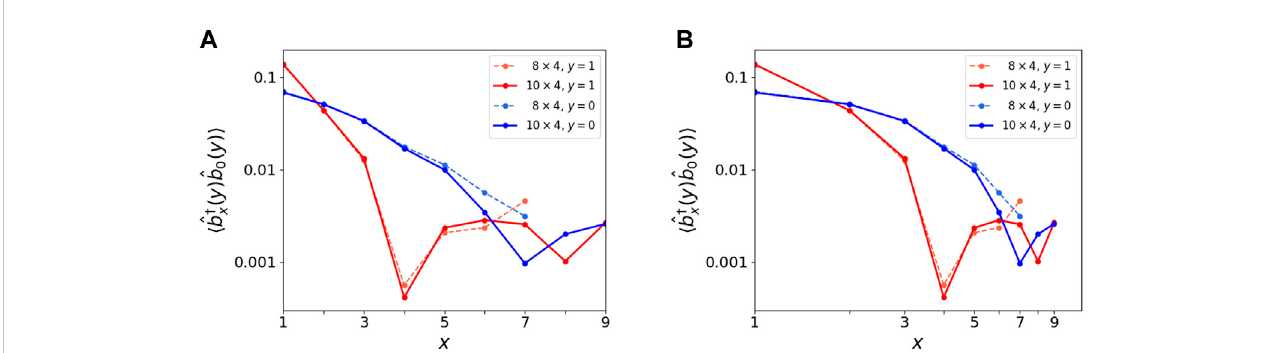
FIGURE 6 Two-point correlation function for the ρ = 1/8 state using open boundary conditions for V = 2 J = 0.02 U in the (A) log-linear scale and (B) log-log scale. Differentshadesofredandbluecolorscorrespondtotherowinthebulk( y =1)andattheedge( y =0).Dashedandsolidlinescorrespondtosystemsizes8×4 and 10 × 4, respectively.